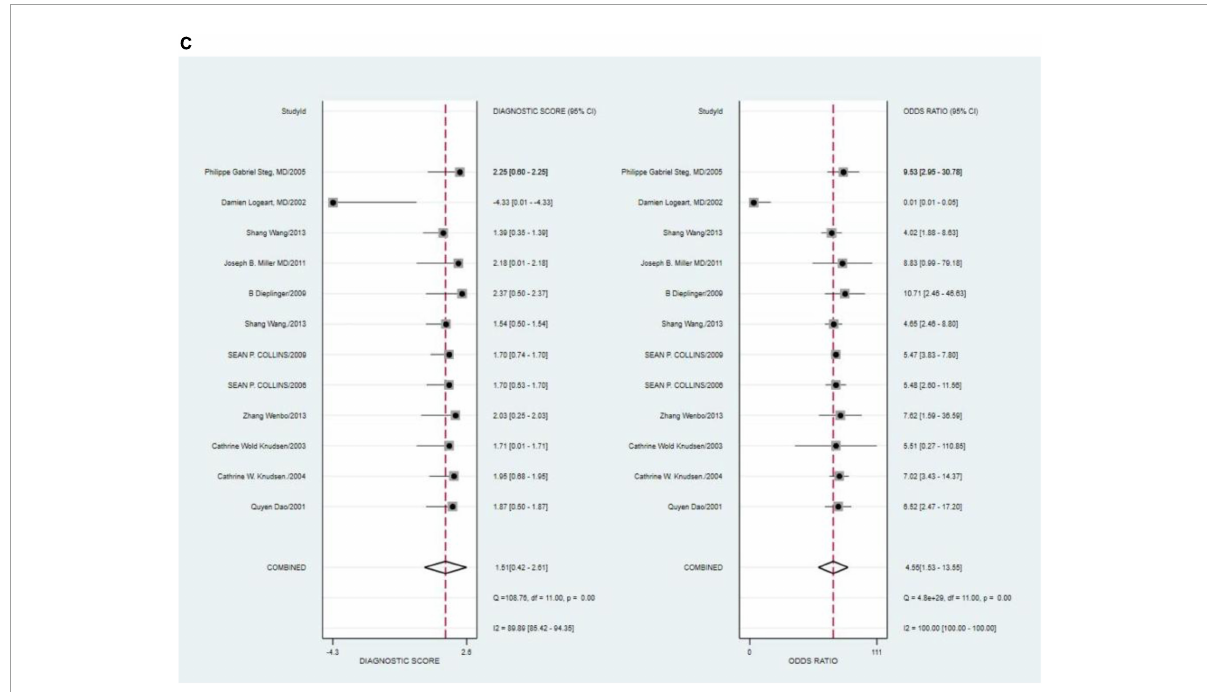
FIGURE2 (A) Forest plot of sensitivity and specificity of third heart sound (S3) in the diagnosis of heart failure (HF). (B) Forest plot of DLR positives and negatives of HF. (C) Forest plot of the diagnostic odds ratio (DOR) of S3 in the diagnosis of HF.